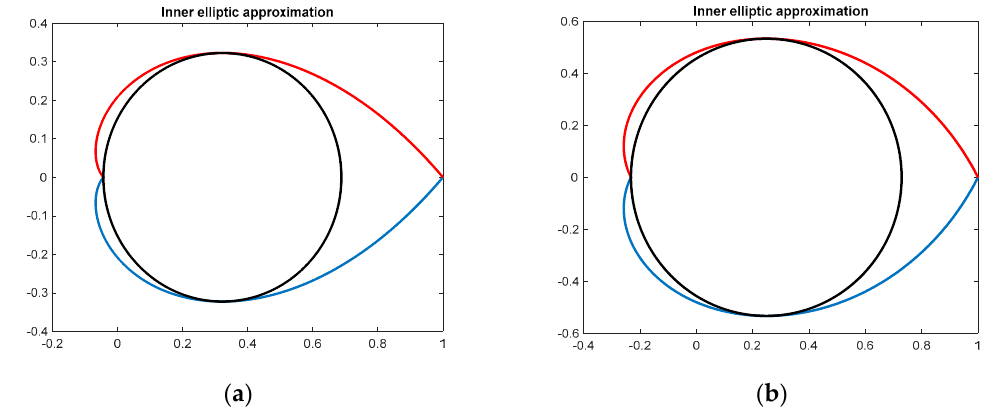
Figure 7. Inner elliptic approximation of cardioid: ( a ) For a 45° damping angle and ( b ) for a 65°